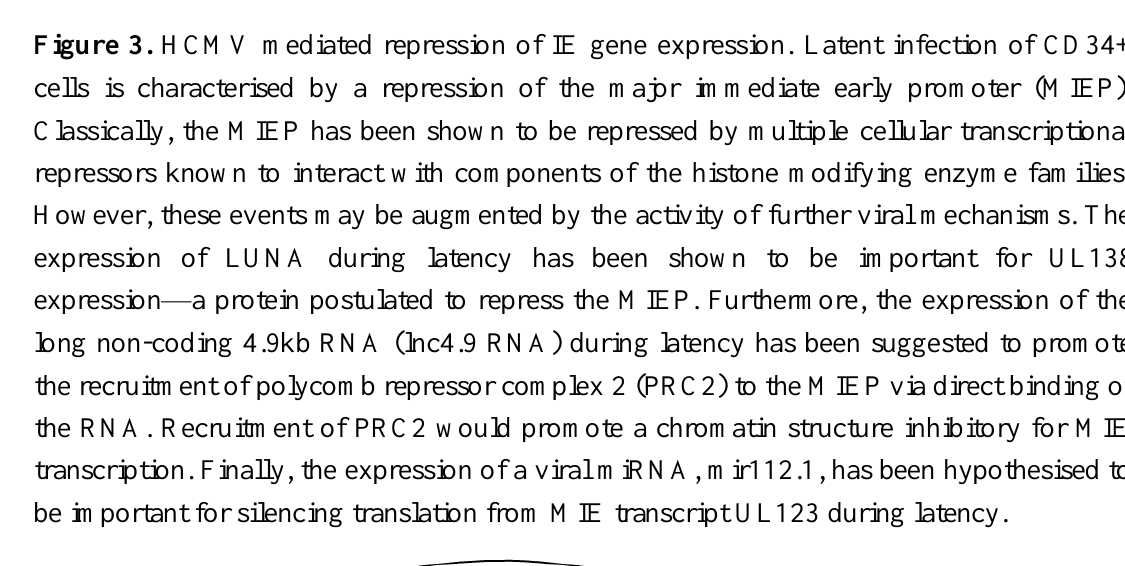
Figure 3. HCMV mediated repression of IE gene expression. Latent infection of CD34+ cells is characterised by a repression of the major immediate early promoter